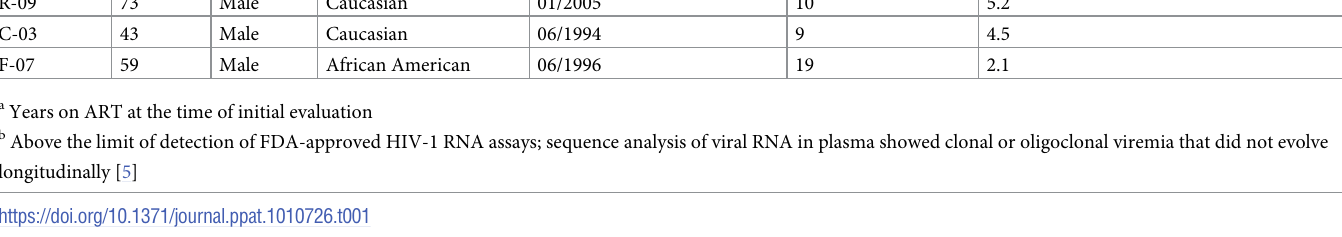
Table 1. Demographics and Clinical Characteristics of Donors with Non-Suppressible Viremia on Antiretroviral Therapy (ART).